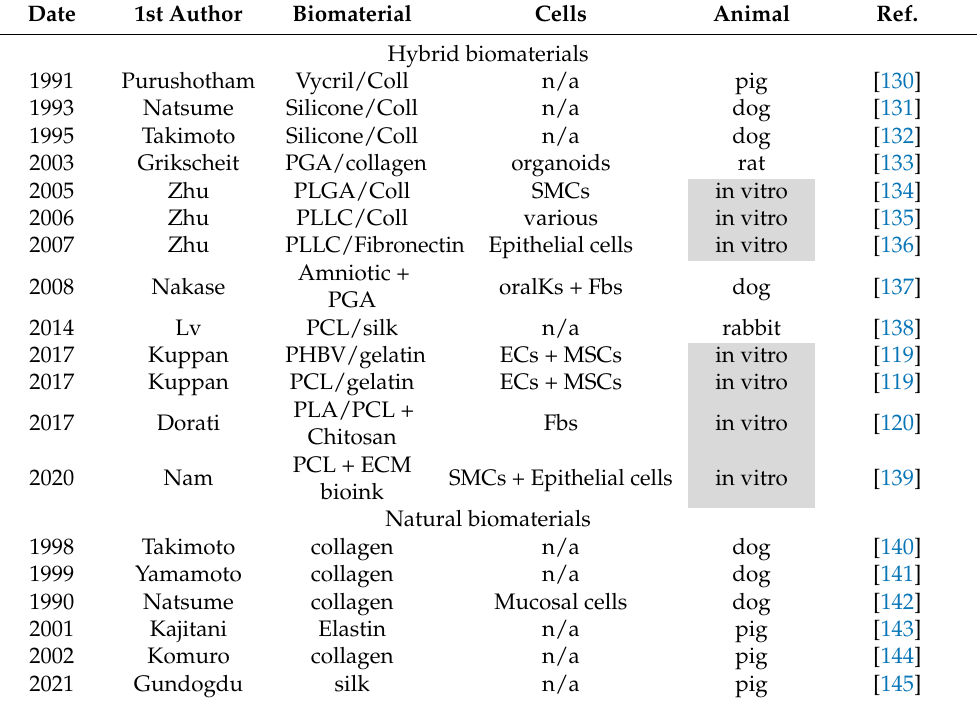
Table 2. Hybrid and natural biomaterial protocols for esophageal reconstruction.